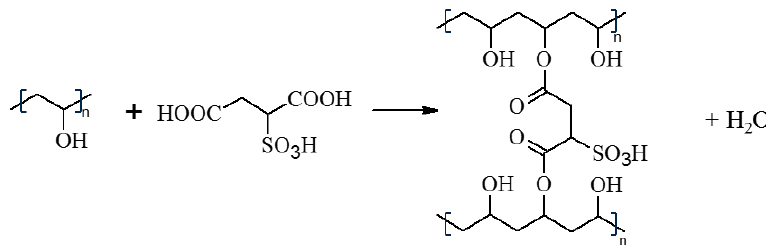
Figure 1. Scheme of the crosslinking reaction between poly(vinyl alcohol) (PVA) and sulfosuccinic acid (SSA).